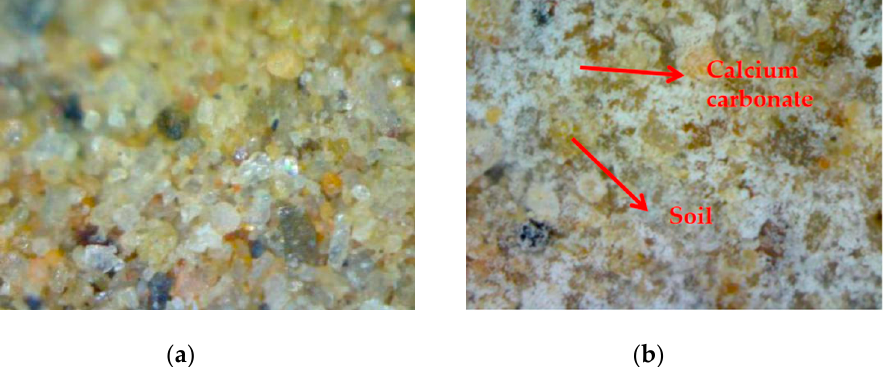
Figure 11. Images of soil under a USB hand-held digital microscope: ( a ) untreated and ( b ) EICP + glutinous rice